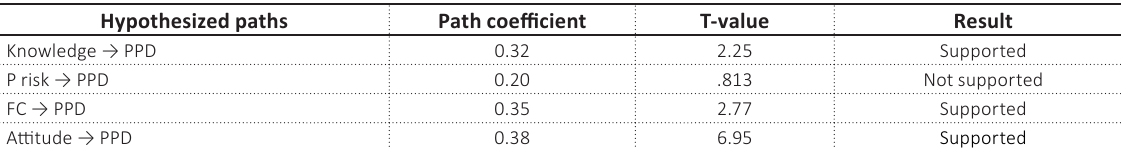
Table 4. Results of structural model